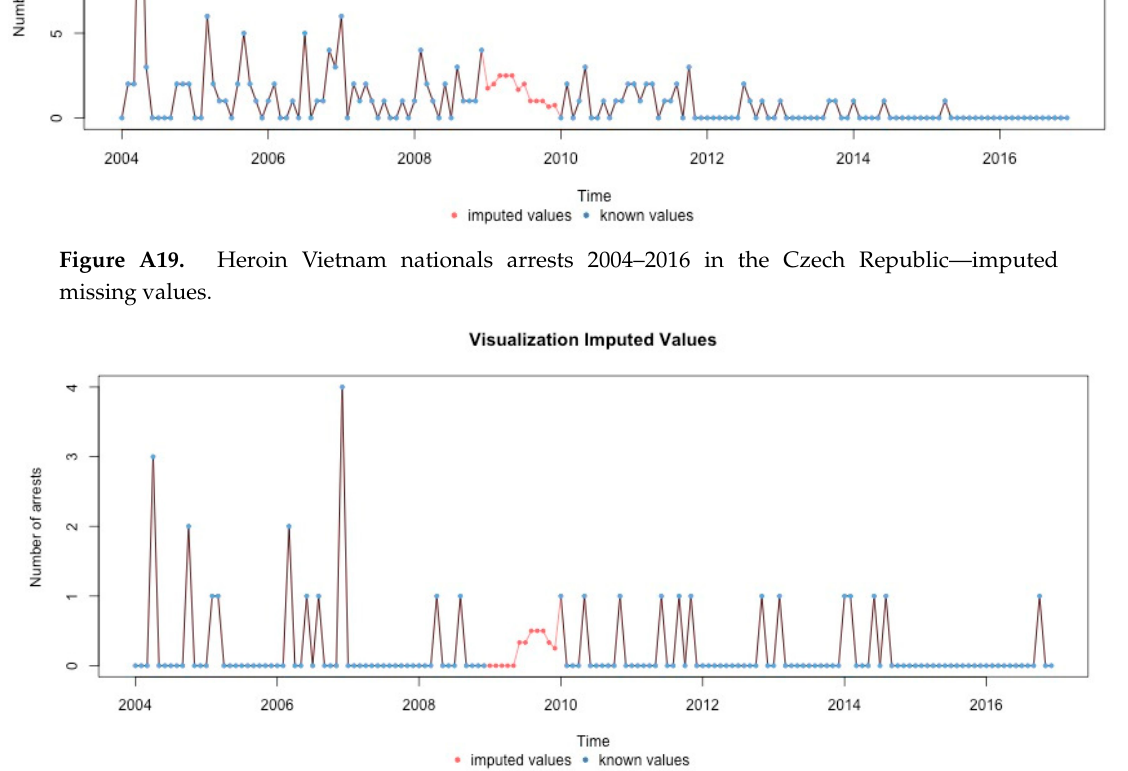
Figure A20. Heroin neighboring country nationals arrests 2004–2016 in the Czech Republic—imputed missing values.